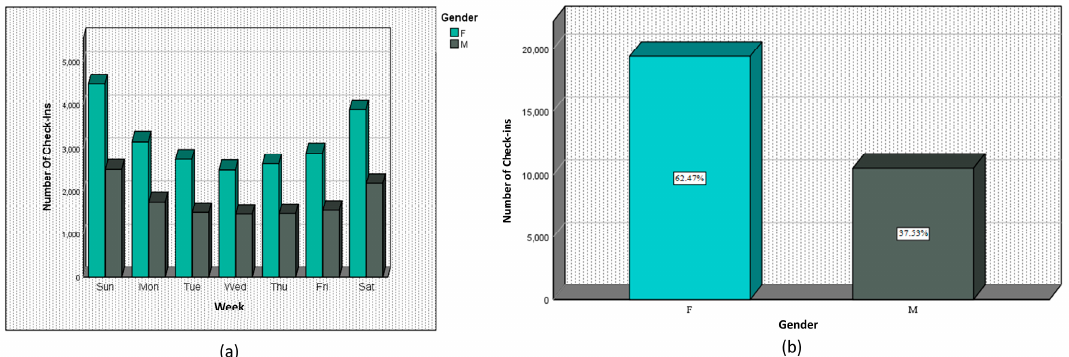
Figure 8. Check-in distribution by ( a ) the day of the week and ( b ) gender.